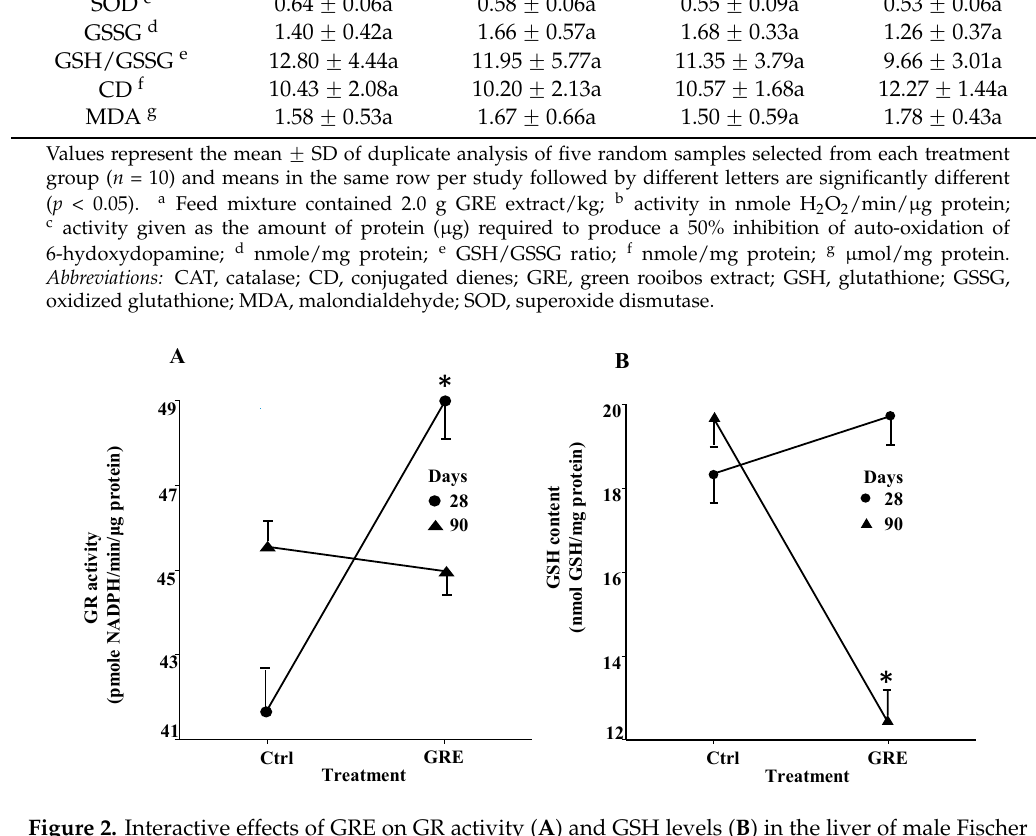
Figure 2. Interactive effects of GRE on GR activity ( A ) and GSH levels ( B ) in the liver of male Fischer rats fed over a period of 28 ( n = 10 per group) and 90 ( n = 10 per group) days, respectively. * Values are means ˘ standard error and differ significantly ( p < 0.05) when compared to the control treatment. Abbreviations: GR, glutathione reductase; GRE, green rooibos extract; GSH, glutathione; NADPH, β -nicotinamide adenine dinucleotide